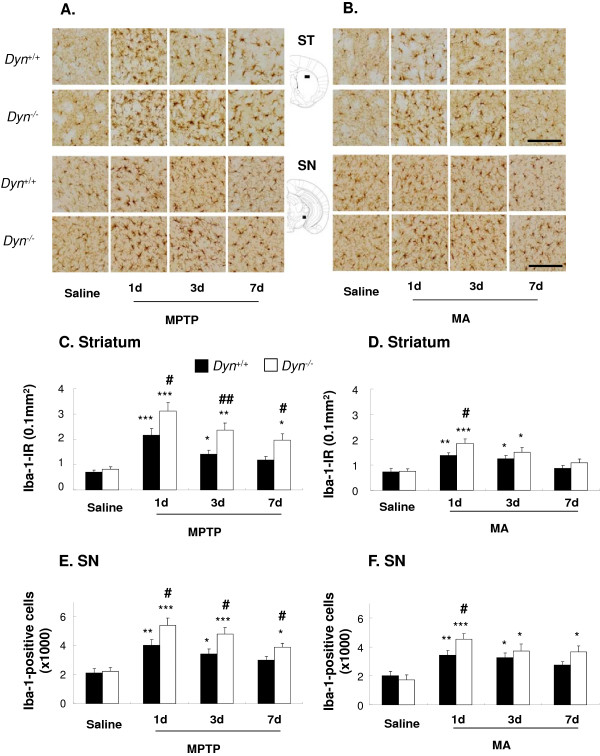
Prodynorphin deficiency amplifies activation of microglia induced by MPTP or MA in the striatonigral areas. Dyn+/+ and Dyn−/− received MPTP (20 mg/kg, i.p./day × 7) or MA (7 mg/kg, i.p./2 h × 4) as described in Figure 1. Microglial activation induced by MPTP or MA was examined by immunocytochemistry with an antibody against Iba1. Striatal sections were collected at 0.62 mm anterior to bregma, while nigral sections were collected at 3.08 mm posterior to bregma according to the atlas of Franklin and Paxinos (2008). Representative photomicrographs of Iba1-immunoreactive cells in the striatum (ST) and substantia nigra (SN) of mice after the last treatment with saline, MPTP, or MA are shown (A, B). Immunostaining of striatal Iba1 immunoreactivity (Iba-1-IR) was quantified by immunoreactive density (C, D) and the number of Iba1-positive neurons in the SN pars compacta was counted by stereological analysis (E, F). For more details, refer to ‘Methods’. Each value is mean ± S.E.M of eight mice. *P <0.05, **P < 0.01, ***P < 0.001 vs. respective saline group, #P <0.05, ##P <0.01 vs. MPTP- or MA-treated Dyn+/+ (two-way ANOVA followed by post-hoc Tukey HSD test or pairwise comparison with paired t-test). Scale bar = 50 μm.